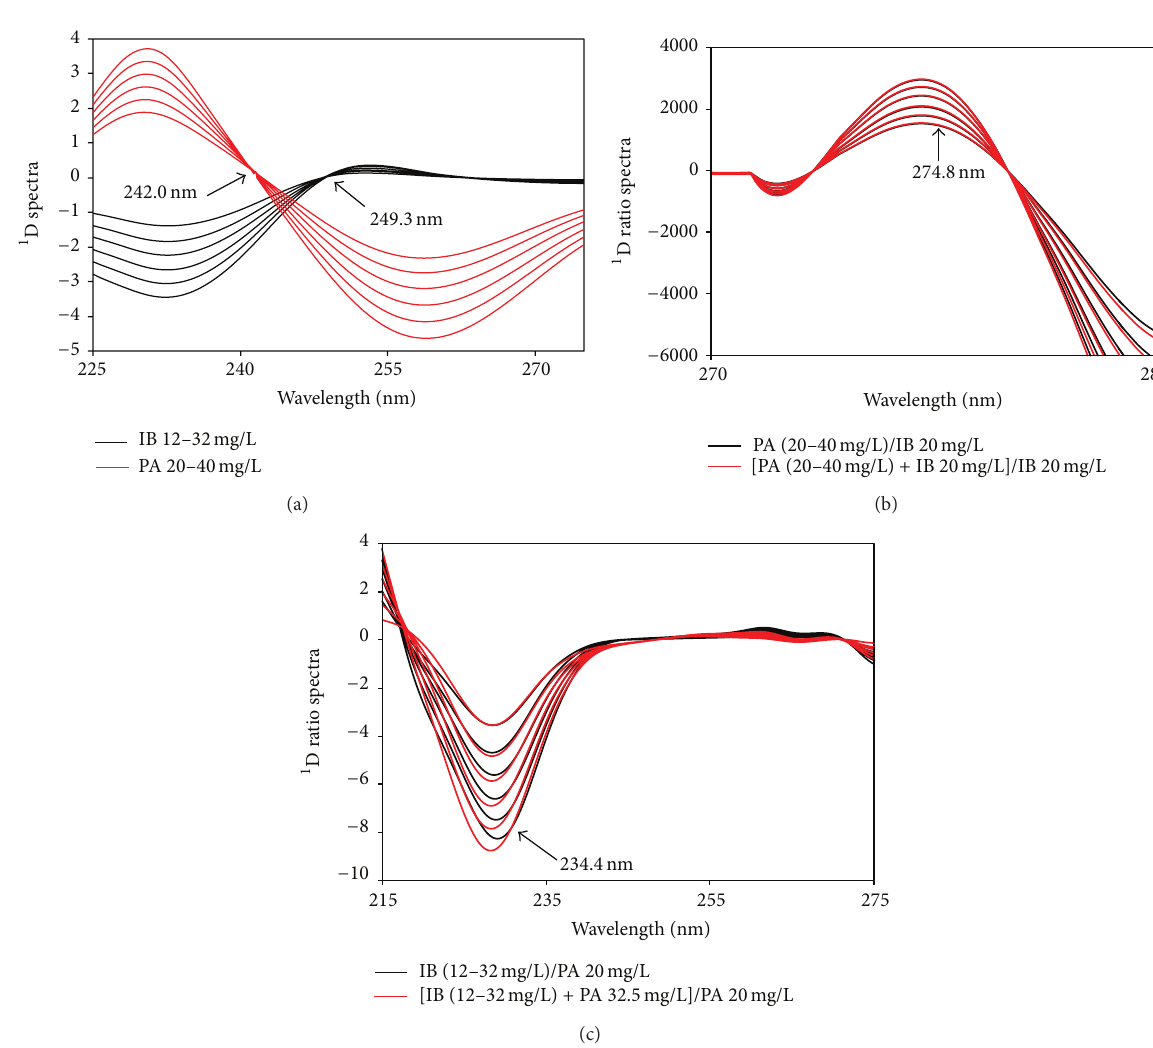
Figure 4: First-order derivatives of spectra (a) and first-order derivatives of ratio spectra (b) and